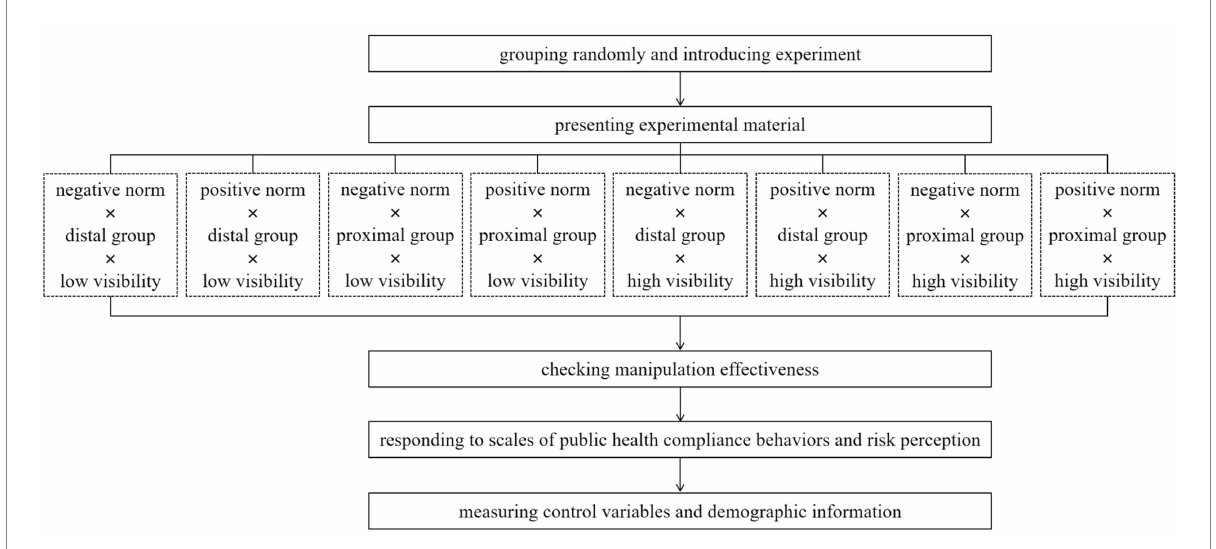
FIGURE 2 The procedure of the survey